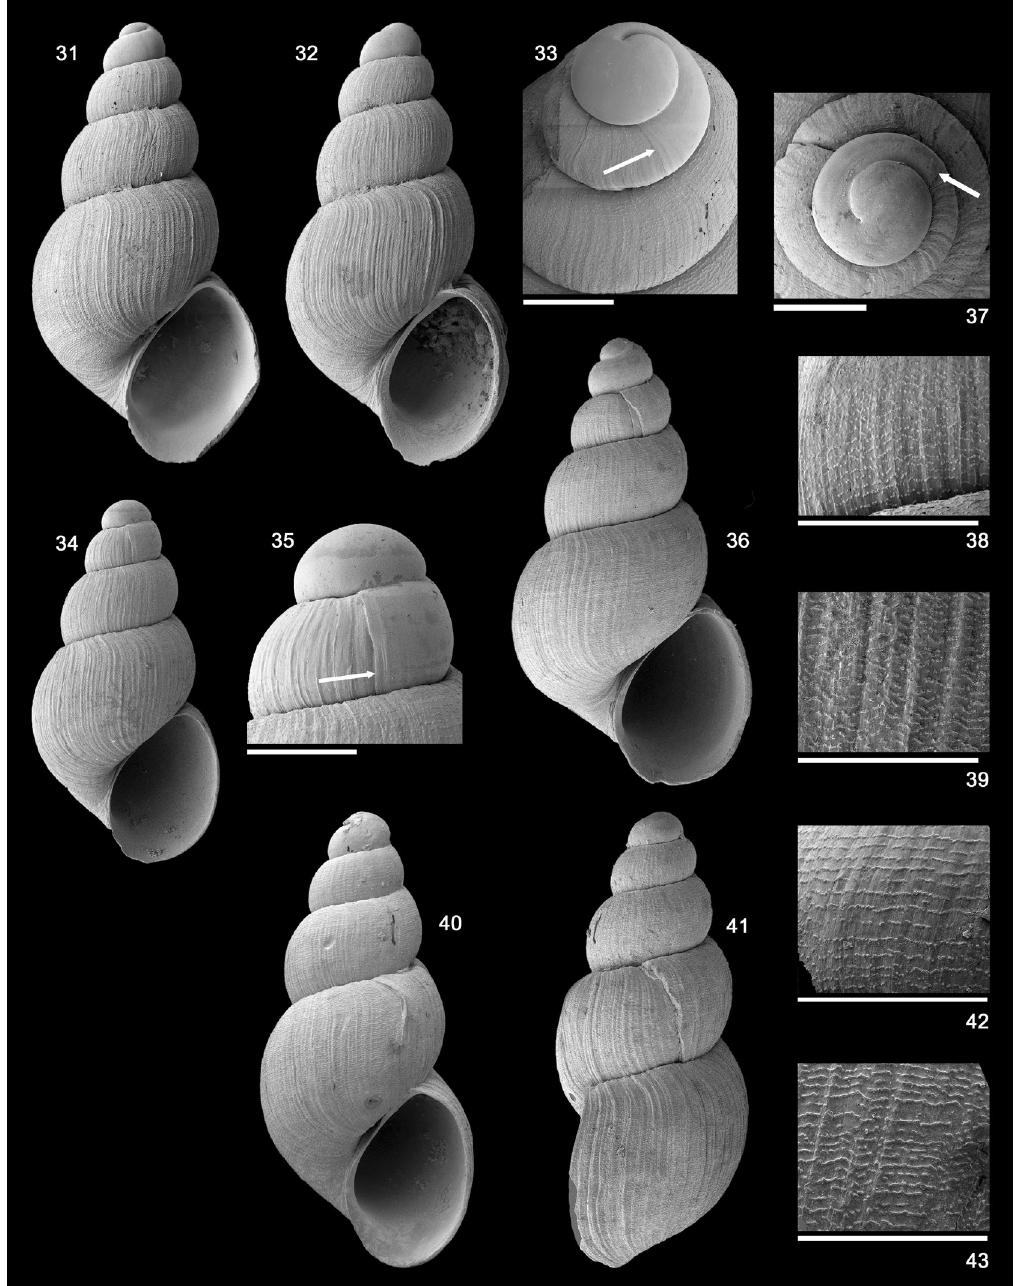
Figs 31–43. Talassia laevapex sp. nov., Mauritania. 31–33 . Banda Mounds, POS346-GeoB11579 (SaM79753). 31 . Ventral view, H = 2.2 mm, W = 1.1 mm. 32–33 . Ventral view, H = 2.2 mm, W = 1.1 mm. 33 . Protoconch, Wp = 0.35 mm. 34–43 . Tamxat Mounds, MSM16/3-GeoB14905. 34–35 . Paratype (SMF358968). 34 . Subadult ventral view, H = 1.8 mm, W = 0.9, Ha = 0.7 mm, apical angle = 34°. 35 . Protoconch, Wp = 0.31 mm, arrow indicates lip. 36–39 . Holotype (SMF358967). 36 . Ventral view, H = 2.2 mm, W = 0.9 mm, Ha = 0.9 mm, apical angle = 31°. 37 . Protoconch, Wp = 0.34 mm, arrow indicates lip. 38 . Sculpture first whorl, teleoconch. 39 . Sculpture body whorl, teleoconch. 40– 43 . Paratype (SMF358968). 40–41 . Ventral and side view, H = 2.2 mm, W = 1.1 mm, Ha = 0.8 mm, apical angle = 36°, Wp = 0.31 mm. 42 . Sculpture first whorl, teleoconch. 43 . Sculpture body whorl, teleoconch. Scale bars = 0.2